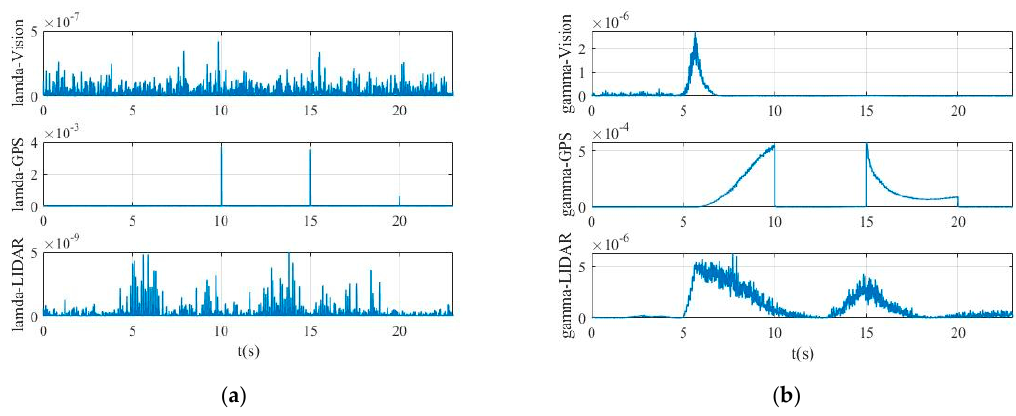
Figure 15. The changes of fault detection function for lateral position in experiment based on: ( a ) double state chi-square detector; and ( b ) residuals chi-square detector.